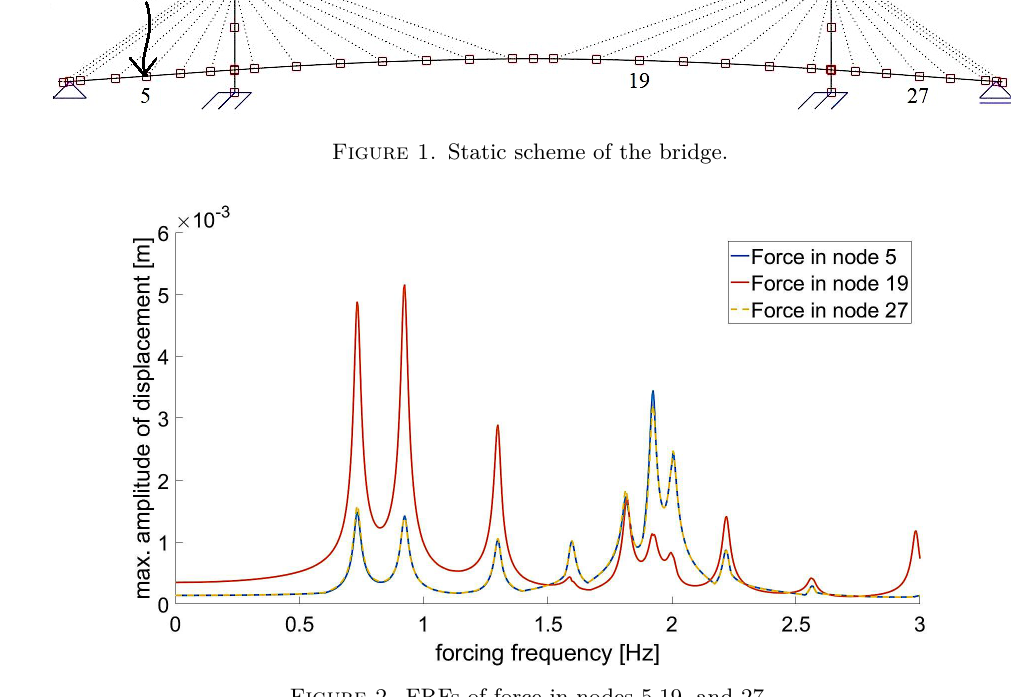
Figure 2. FRFs of force in nodes 5,19, and 27.